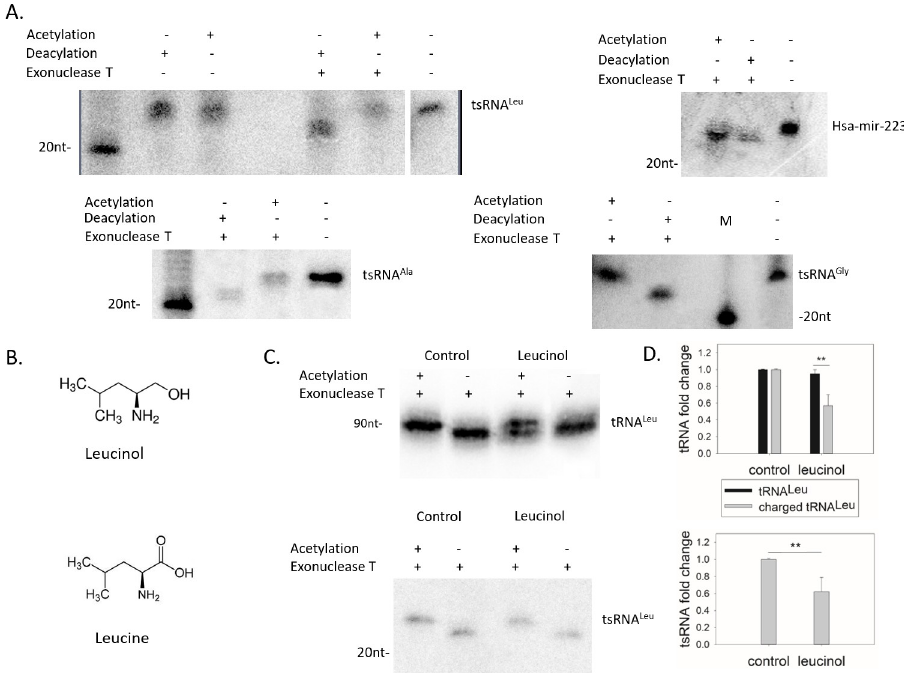
Fig 2. 3´tsRNAs are fully charged. All experiments were performed in triplicate and representative northern blots are shown. (A) Under normal growth conditions, 3´tsRNAs are aminoacylated. HeLa total RNA extracted under conditions with pH less than 5.0 was either acetylated or deacylated, ethanol precipitated, and exonuclease T digested. A 20 nt size marker was loaded in each gel and total RNA without any treatment was used for comparison in the right lane. DNA probes antisense to tsRNA Leu , tsRNA Ala , and tsRNA Gly were used in a northern blot (top left panel and bottom panel). The hsa-miR-223-3p miRCURY LNA miRNA (Qiagen) detection probe was used for quantifying this miRNA (top right panel). (B) Leucinol is an analog of leucine and an inhibitor of LARS1. (C) The tsRNA Leu is fully charged in the presence of leucinol. Total RNA isolated from HeLa cells grown with or without leucinol (2 mM) were extracted and examined for their charging status. The full-length tRNA Leu was ~50% charged under this condition (top) while the tsRNA Leu is fully charged (bottom). (D) Quantification of tRNA Leu and tsRNA Leu in the presence or absence of leucinol. Values were normalized to control cells. Data are means ± standard deviations (s.d.), n = 3 independent experiments, �� , P < 0.01, as determined by Student’s one-tailed